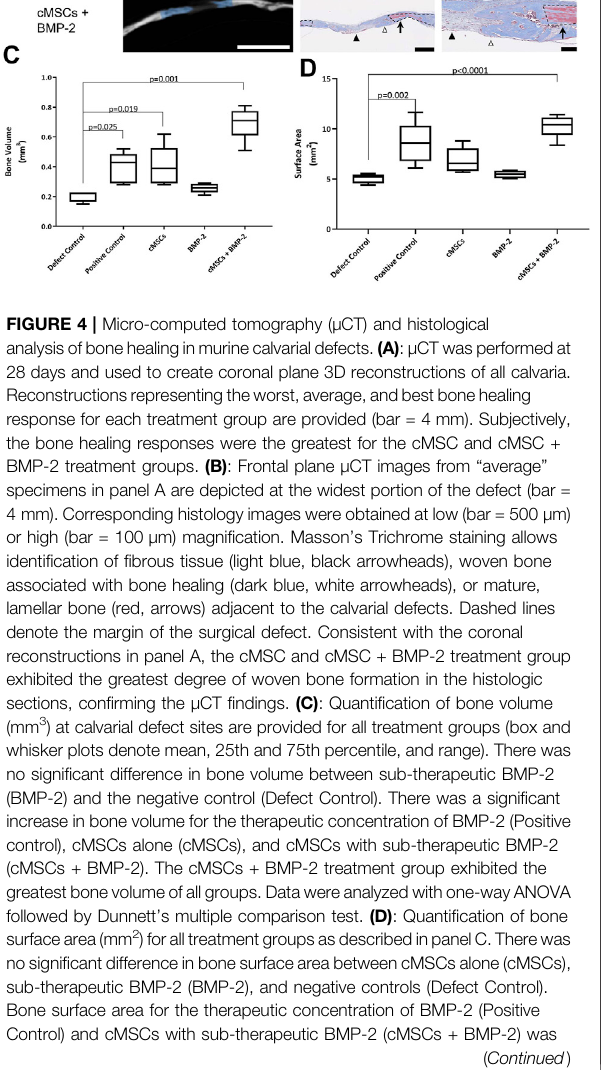
FIGURE 4 | signi fi cantly greater than negative controls (Defect Control). The cMSCs + BMP-2 treatment group exhibited the greatest bone surface area of all groups. These results demonstrate that while cMSCs are capable of inducing a bone healing response superior to un-treated defects,